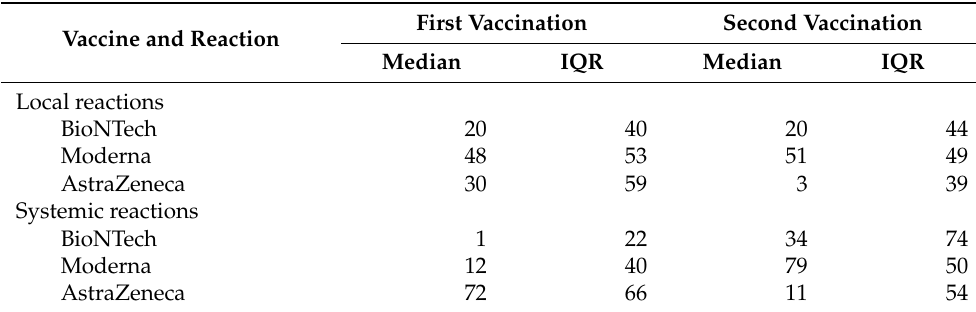
Table 3. Median values and interquartile ranges of the visual analog scale for local and systemic reactions depending on the vaccine.